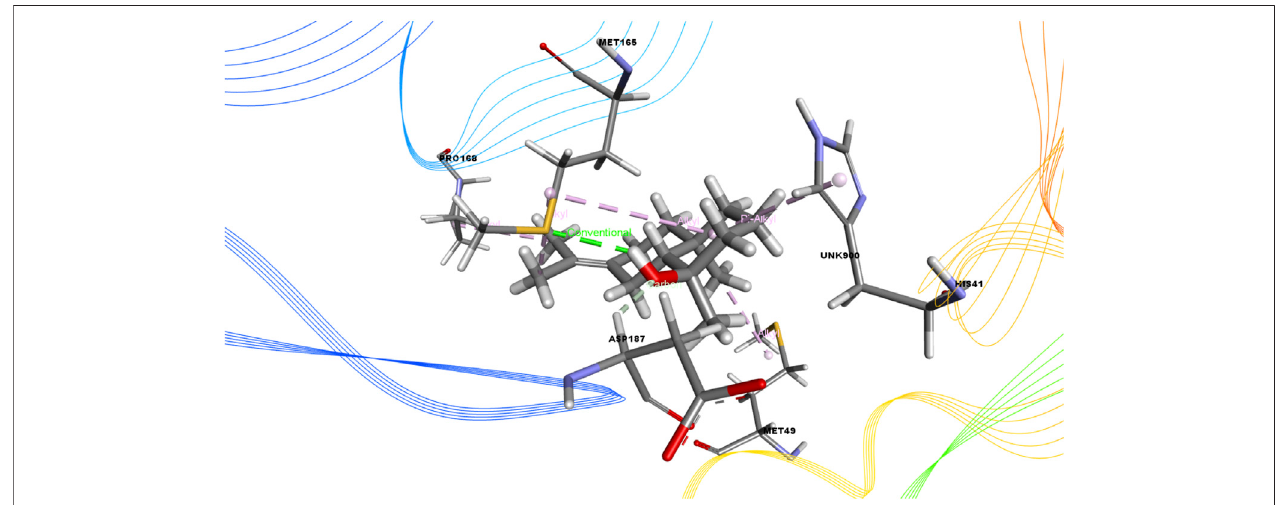
FIGURE 2 | 3D interactions of Juniper camphor with the active site of SARS-CoV-2 main protease (PDB ID: 6W63).